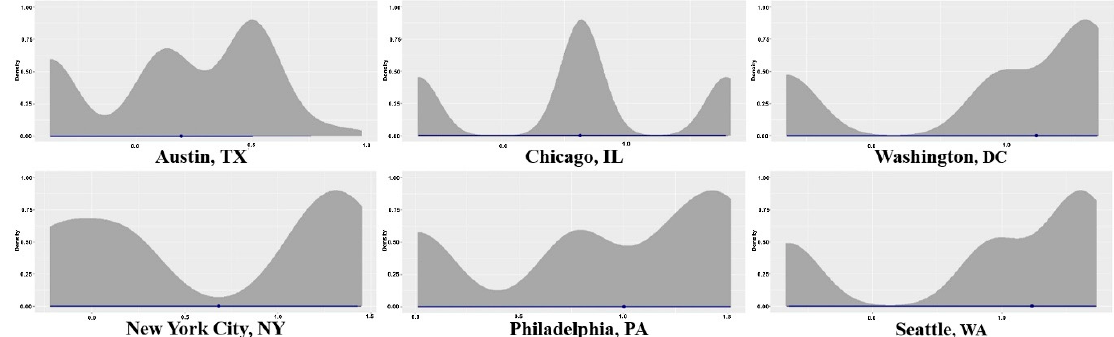
Figure 4. Posterior distribution of the impacts of morphological density on EUI by city.